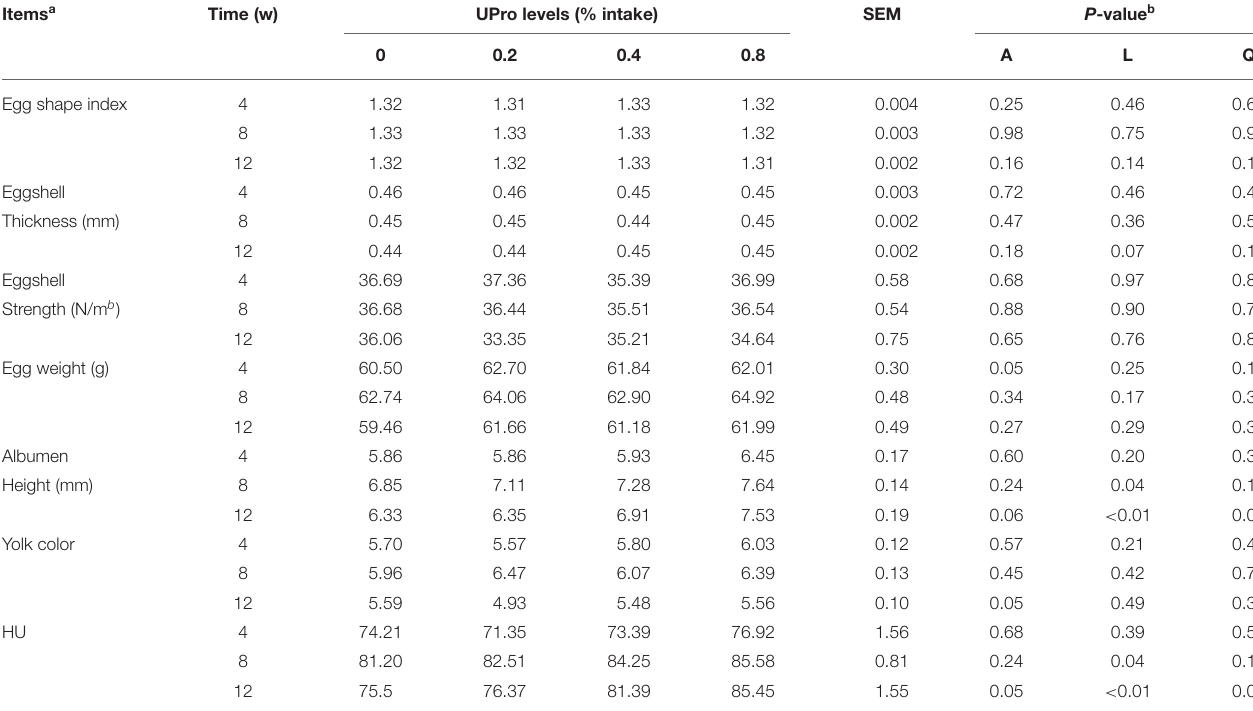
TABLE 4 | Effects of dietary UPro on egg quality of laying hens.